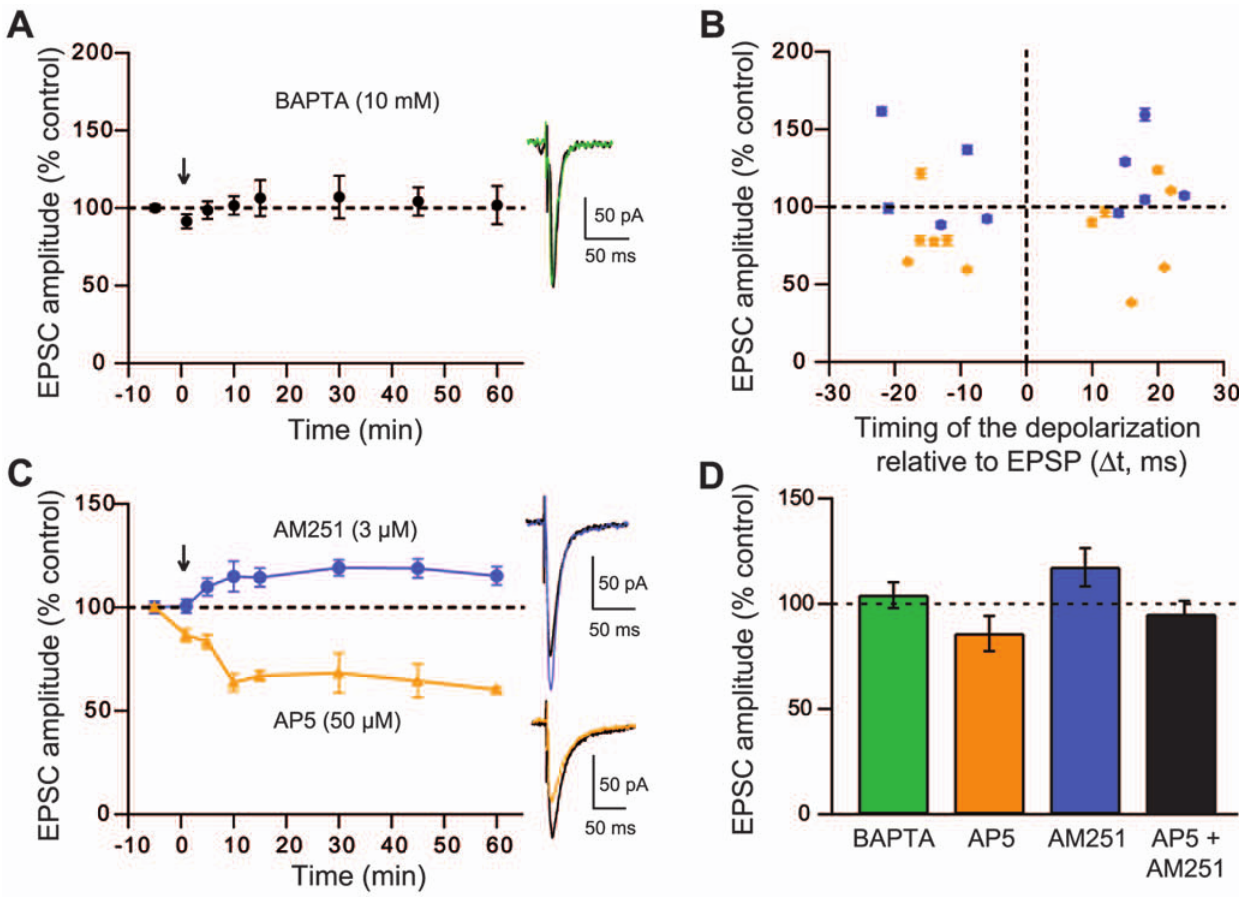
Figure 5. Pharmacological characterization of SDDP. ( A ) sdLTD and sdLTP are Ca 2 + -dependent. Mean effects of BAPTA for 2 50 , D t , + 50 ms post-pre and pre-post SDDP sequences. When MSNs were loaded with BAPTA (10 mM, in whole-cell pipettes), SDDP protocols did not induce any long-term synaptic efficacy changes ( + 4.2 6 9.1%, n=6, 2 50 , D t , + 50 ms), indicating that the SDDP is Ca 2 + -dependent. The absence of synaptic efficacy changes is also illustrated by representative EPSCs evoked before (black traces) or 60 minutes after SDDP sequences (green trace). ( B ) Pharmacology of SDDP was explored for 2 30 , D t , + 30 ms (each symbol represent one MSN, mean 6 SEM measured 60 minutes after cellular conditioning protocol). AP5 treatment (orange diamonds, n=10) induces mainly sdLTD for post-pre and pre-post sequences. Treatment with AM251 (purple dots, n=8) leads to sdLTP or absence of plasticity. ( C ) Representative experiments illustrate the effect of treatments with AM251 or AP5. In presence of AP5 (orange trace), a sdLTD is observed ( 2 35.6 6 8.1%) and with AM251 treatment (purple trace), a sdLTP is observed ( + 18.8 6 4.6%). Representative EPSCs evoked before (black traces) or 60 minutes after SDDP sequences (orange or purple traces) also illustrate the long-term plasticity observed in presence of AP5 (sdLTD) or in presence of AM251 (sdLTP). ( D ) Histograms of long-term synaptic efficacy changes in BAPTA (green bars, n=6), AP5 (orange bars, n=12), AM251 (purple bars, n=10) and with co-administration of AP5 and AM251 (black bars, n=4): synaptic plasticity was Ca 2 + -dependent, sdLTD was CB1 receptor-activation dependent and sdLTP was NMDA receptor-activation dependent. Postsynaptic depolarizations evoked during pharmacological experiments were not significantly different than those induced for post-pre and pre-post SDDP sequences (27.4 6 1.1 mV versus 27.9 6 0.9 mV,